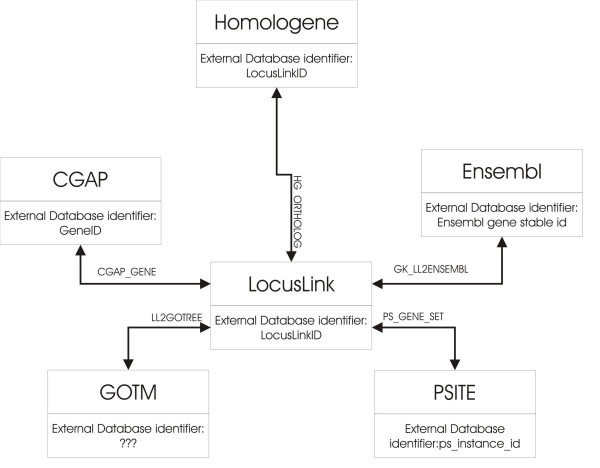
GeneKeyDB sub-modules, external database identifiers and connecting tables. The connecting tables may convert between the central key and another unique key used throughout the sub-module and are shown next to the connector lines.